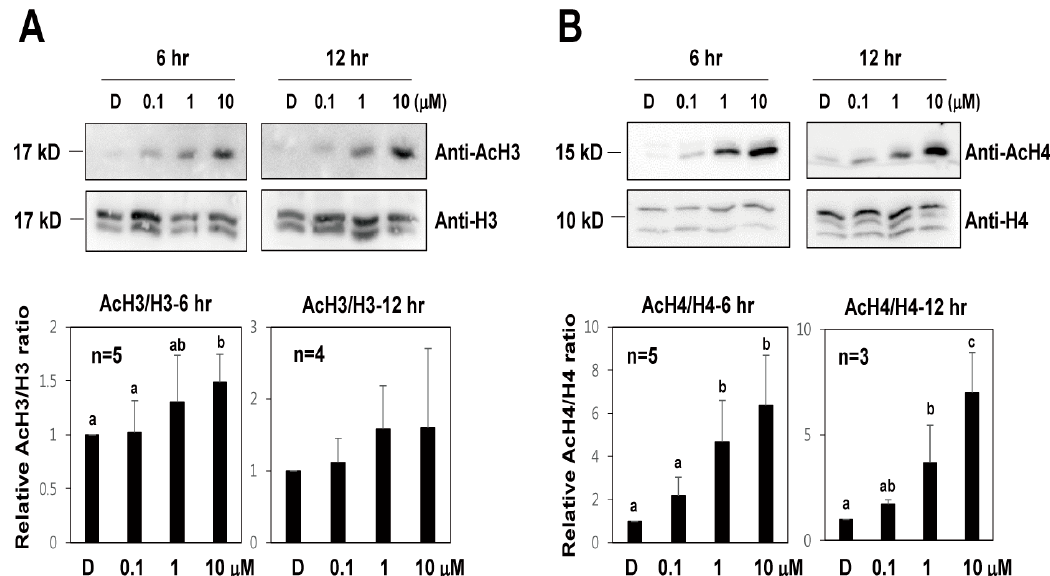
Figure 5. The effect of TSA on histone H3 and H4 acetylation level in lettuce protoplasts. Total protein extracts were obtained from lettuce protoplasts after 6 or 12 h after TSA treatments. Error bars represent SD ( n = 3 or more). ( A ) H3 Histone acetylation levels were determined with a Western blot using an anti-H3 and anti-AcH3 antibody. ( B ) H4 histone acetylation levels were determined with a Western blot using an anti-H4 and anti-AcH4 antibody. Different letters on the bars indicate significant differences between each treatment. H3 = histone H3 antibody; AcH3 = acetylated histone H3 antibody; H4 = histone H4 antibody; AcH4 = acetylated histone H4 antibody.